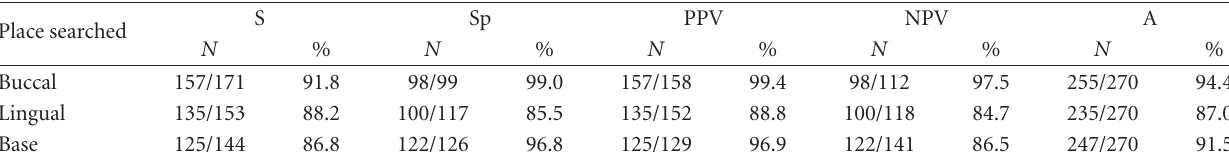
Table 4: Evaluation of the sensitivity (S), specificity (Sp), positive predictive value (PPV), negative predictive value (NPV), and accuracy (A), according to the place searched, in the study of the presence or absence of simulated lesions.